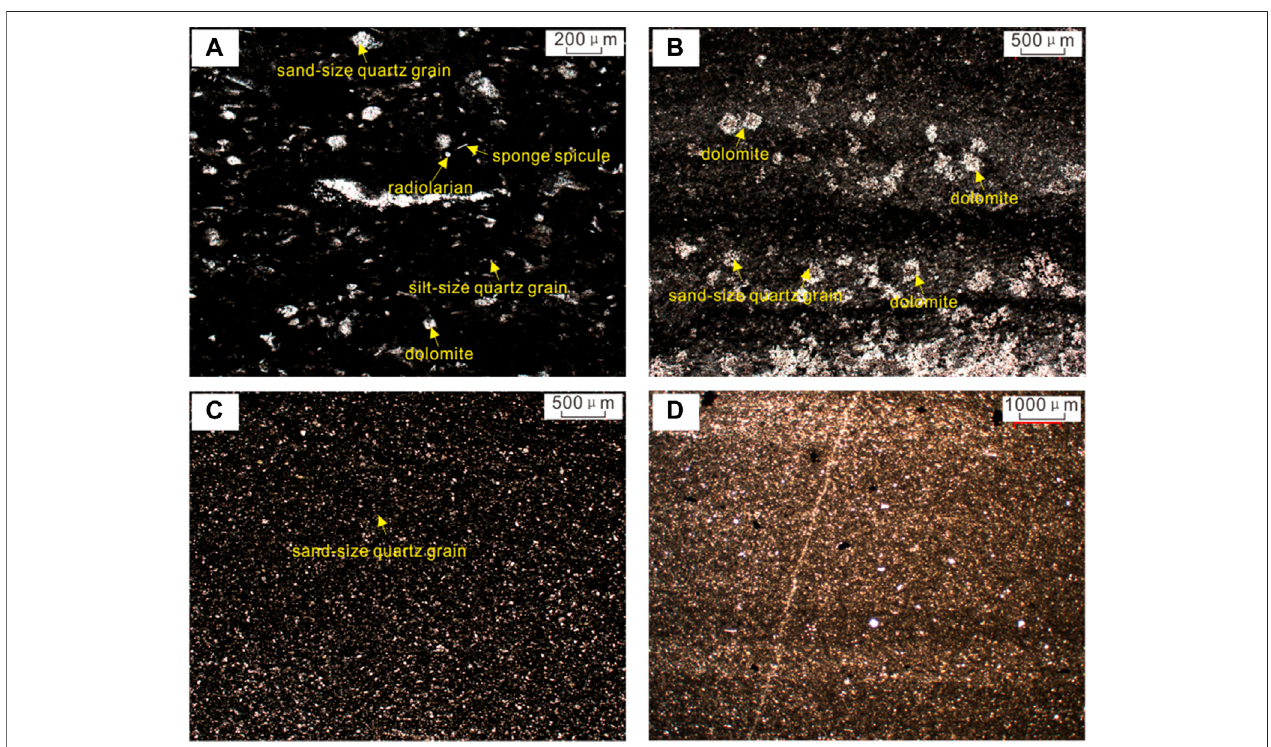
FIGURE 3 | Thin section photomicrograph for the Upper Permian Linghao Formation shale/mudstone from the studied well in Nanpanjiang Basin. (A) Thin section image (transmitted light) showing the presence of sponge spicule, radiolarian, silt size quartz grains, sand size quartz grains, and dolomite grains in organic-rich shale, Ling1member,3,773.11 m. (B) Thinsectionimage(transmittedlight)showingthepresenceofsandsizequartzgrainsanddolomitegrainsinmudstone,Ling2member, 3,556.10 m. (C) Organic-rich shale containing sand size quartz grains, Ling 3 member, 3,414.88 m. (D) Shale containing sand size quartz grains, Ling 3 member, 3310